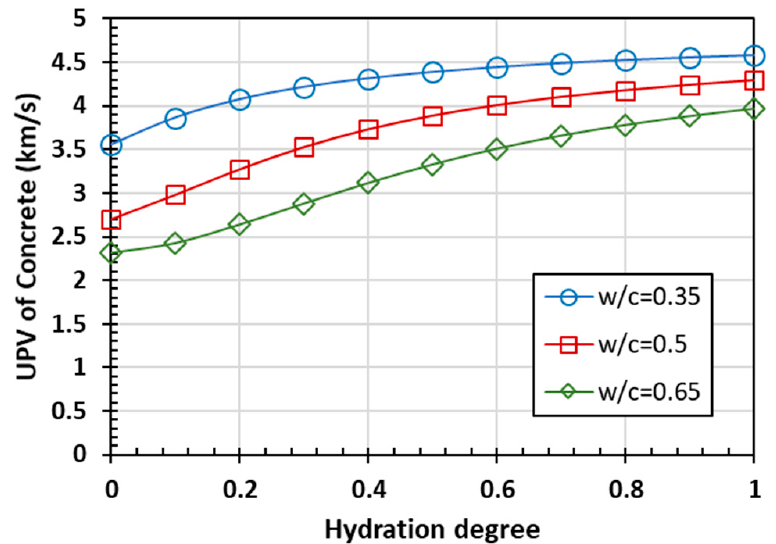
Figure 9. The ultrasonic pulse velocity prediction of concrete.